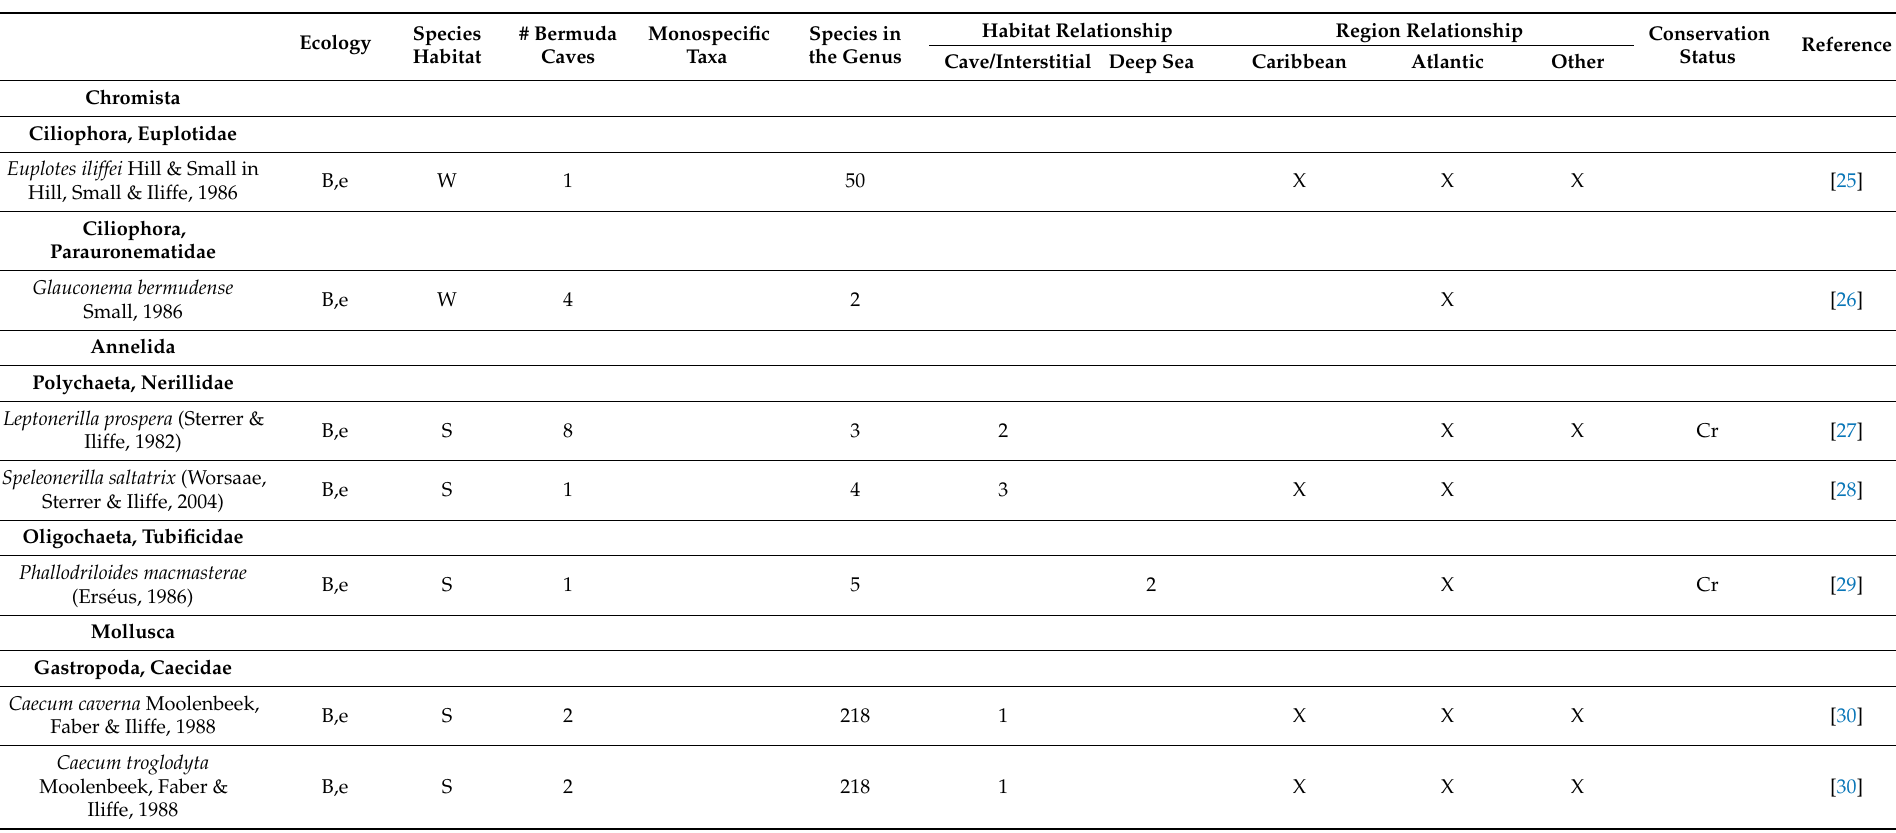
Table 1. Cave species inhabiting the Walsingham Tract in Bermuda. Ecology (B = Stygobiont, P = Stygophile, e = endemic to Bermuda). Species habitat (W = Water column, S = Sediment/interstitial). # Bermuda’s caves (from where the species has been recorded). Monospecific taxa (belong to higher taxa to which they are the only representative, O = Order, G = Genus). Habitat and Region relationships (related species in the immediate superior taxa, “+” = numerous). Conservation status (in accordance with the IUCN Red List [23], Cr = Critically Endangered). Taxonomic status was validated in WoRMS